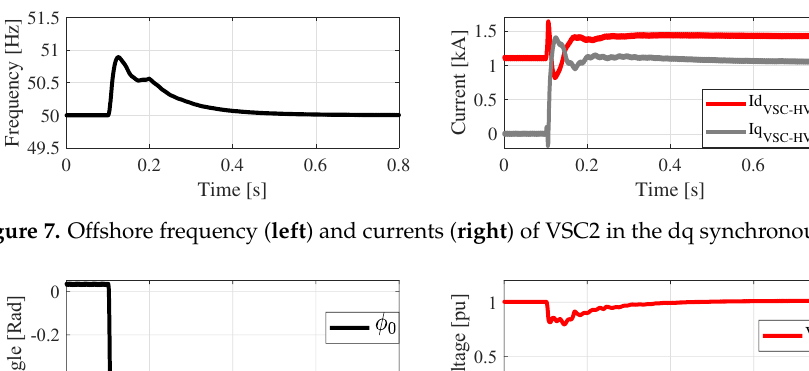
Figure 6. The voltage of offshore common coupling point (PCC) ( left ) and currents ( right ) of OWF and transmission lines when the HVAC link trips.